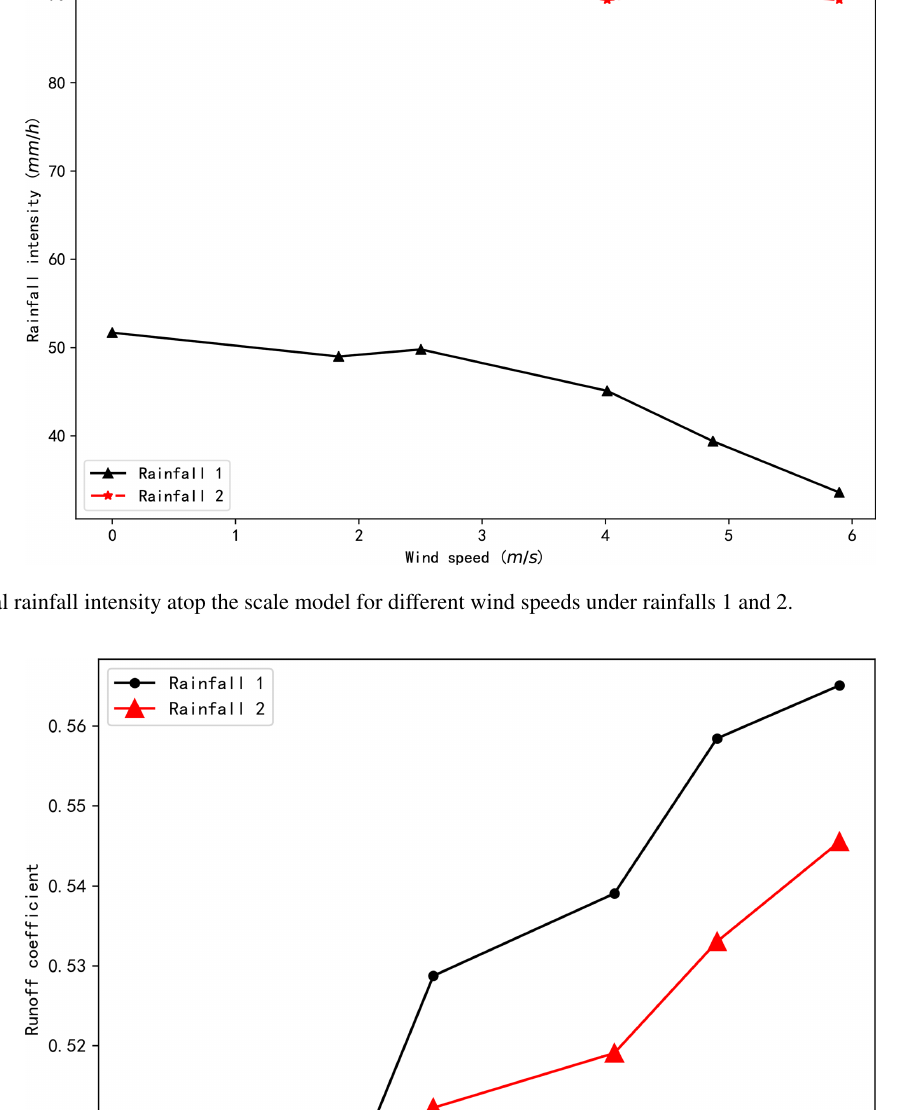
a lower horizontal velocity and shorter drift distance.